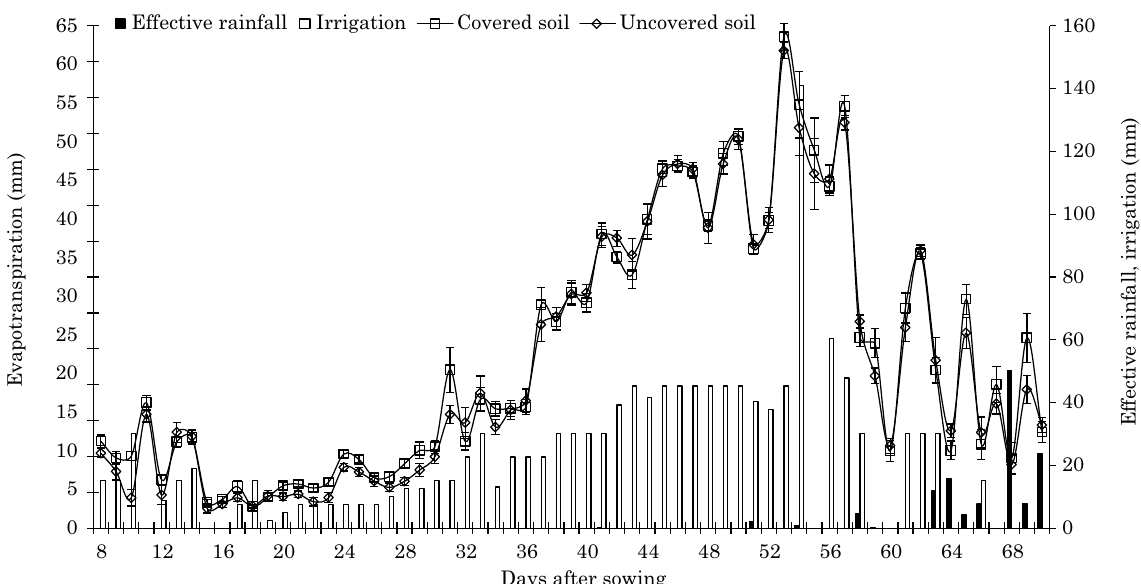
Figure 7. average daily evapotranspiration, with the corresponding standard deviations, rainfall, and irrigation throughout the muskmelon